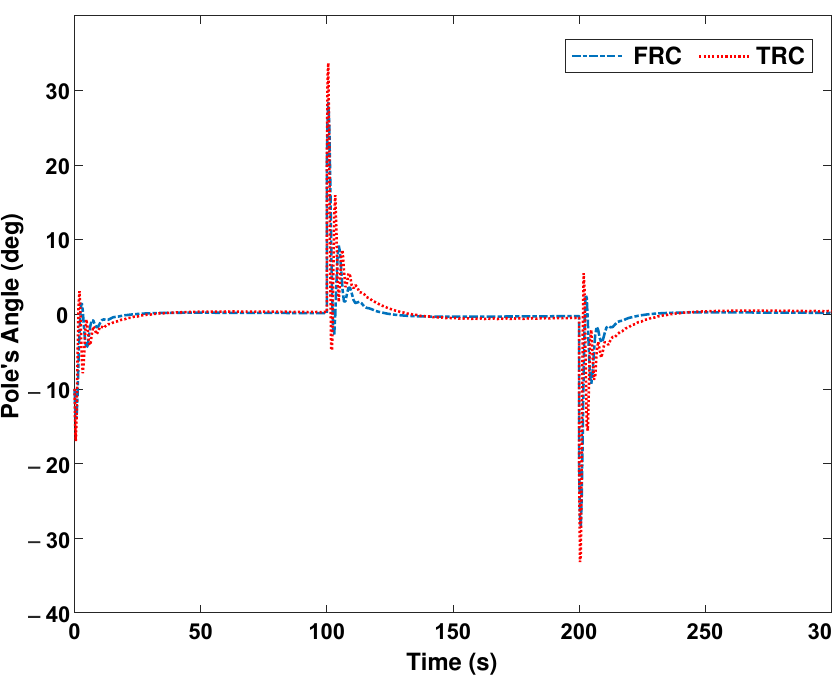
Figure 10. Angle control of inverted pendulum by FRC and